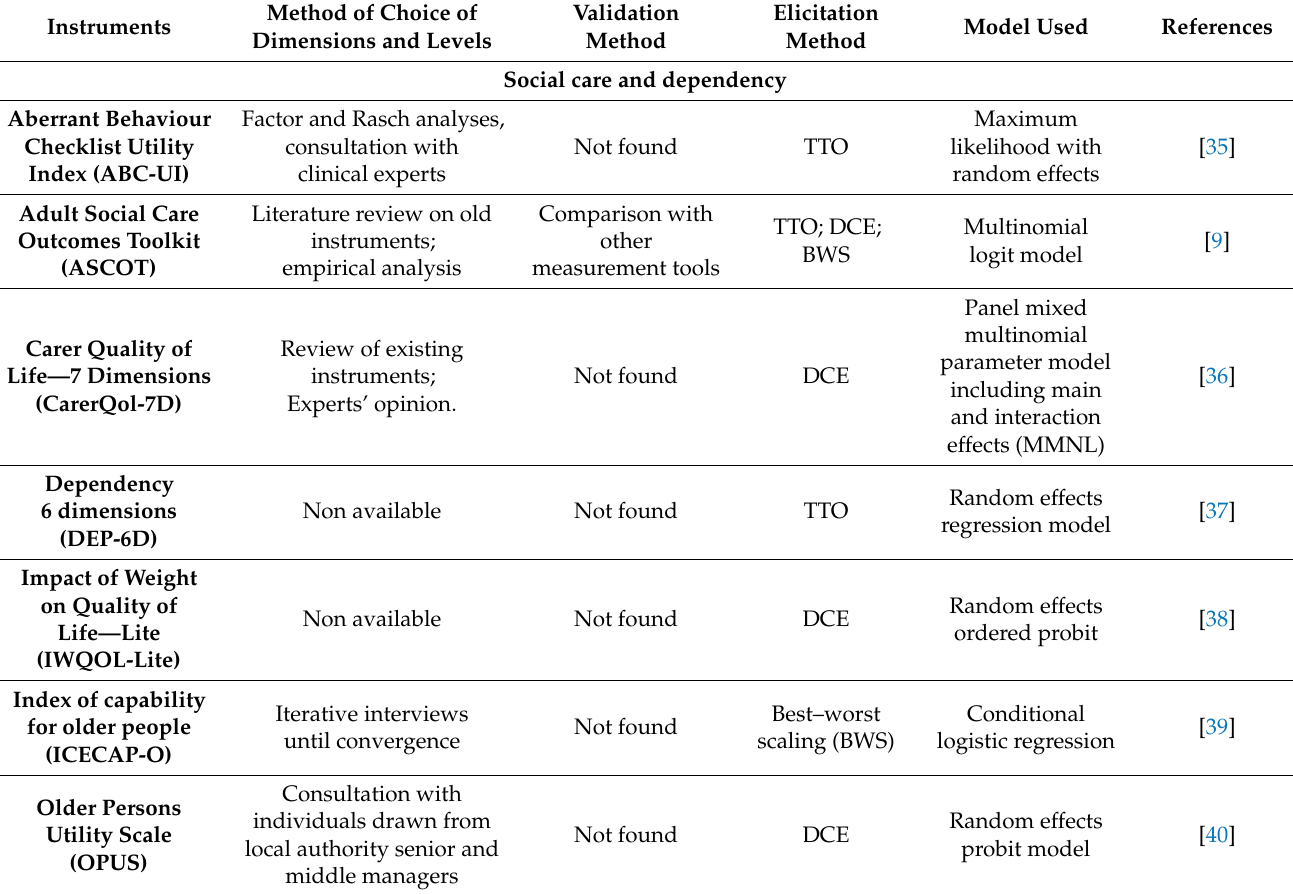
Table 4. Methods used for the development of specific